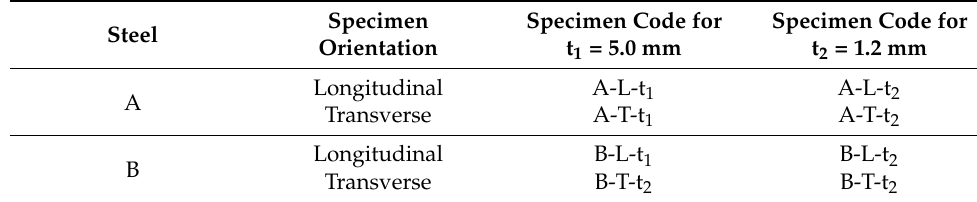
Table 2. Specimen marking depending on their cutting orientation and thickness.